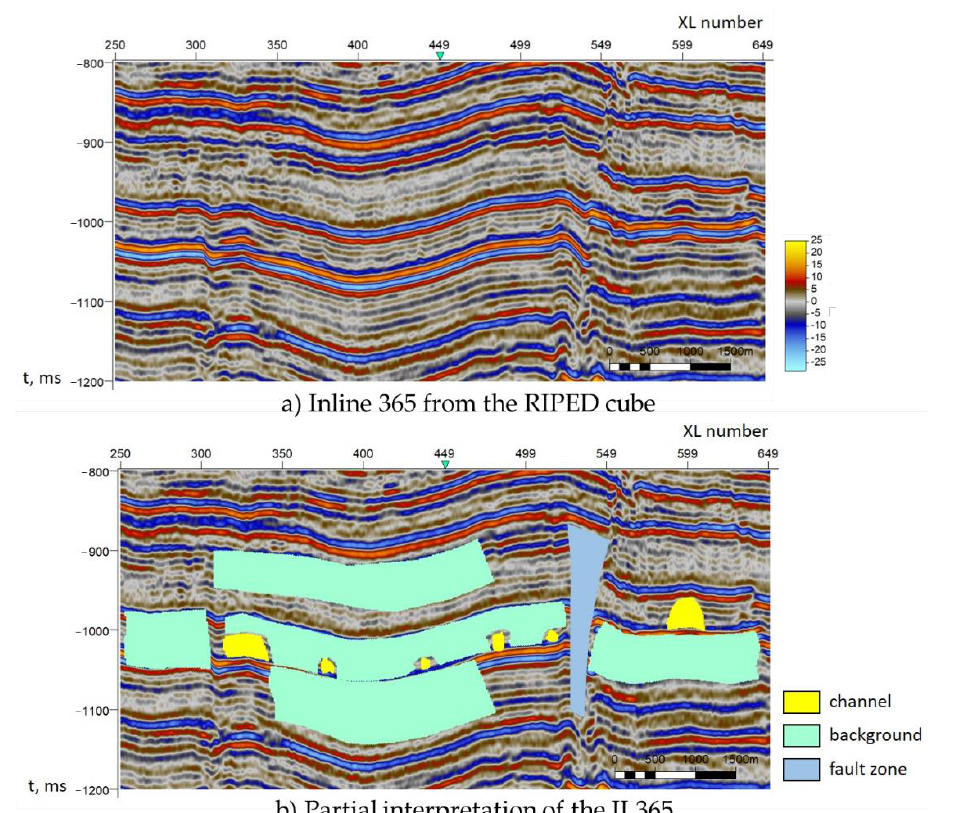
Figure 5. Partial interpretation of the IL365 from the RIPED 3D cube ( a ) along with the initial seismic section ( b ). The goal of using this kind of interpretation was to test the limits of the algorithms while reducing labeling costs.